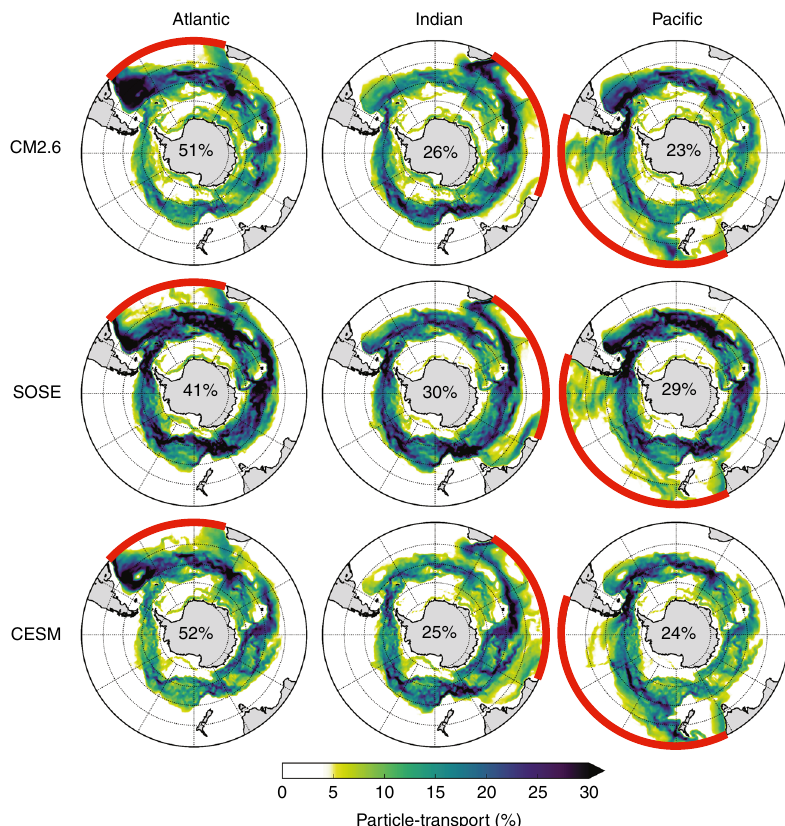
Fig. 5 Particle pathways from 30° S to the mixed layer. Maps of the percent of total basin upwelling particle transport visiting each 1° latitude × 1° longitude grid column at some time during the 200 year experiment from release at 30° S and before reaching the surface mixed layer for CM2.6, SOSE, and CESM. The percentages of particle transports originating in the Atlantic, Indian, and Paci fi c (release locations at 30° S marked in red ) are shown separately, normalized by the total upwelling particle transport originating in each basin. The percentages in the center of each panel indicate the relative contribution of the Atlantic, Indian, and Paci fi c to the total upwelling particle transport in each